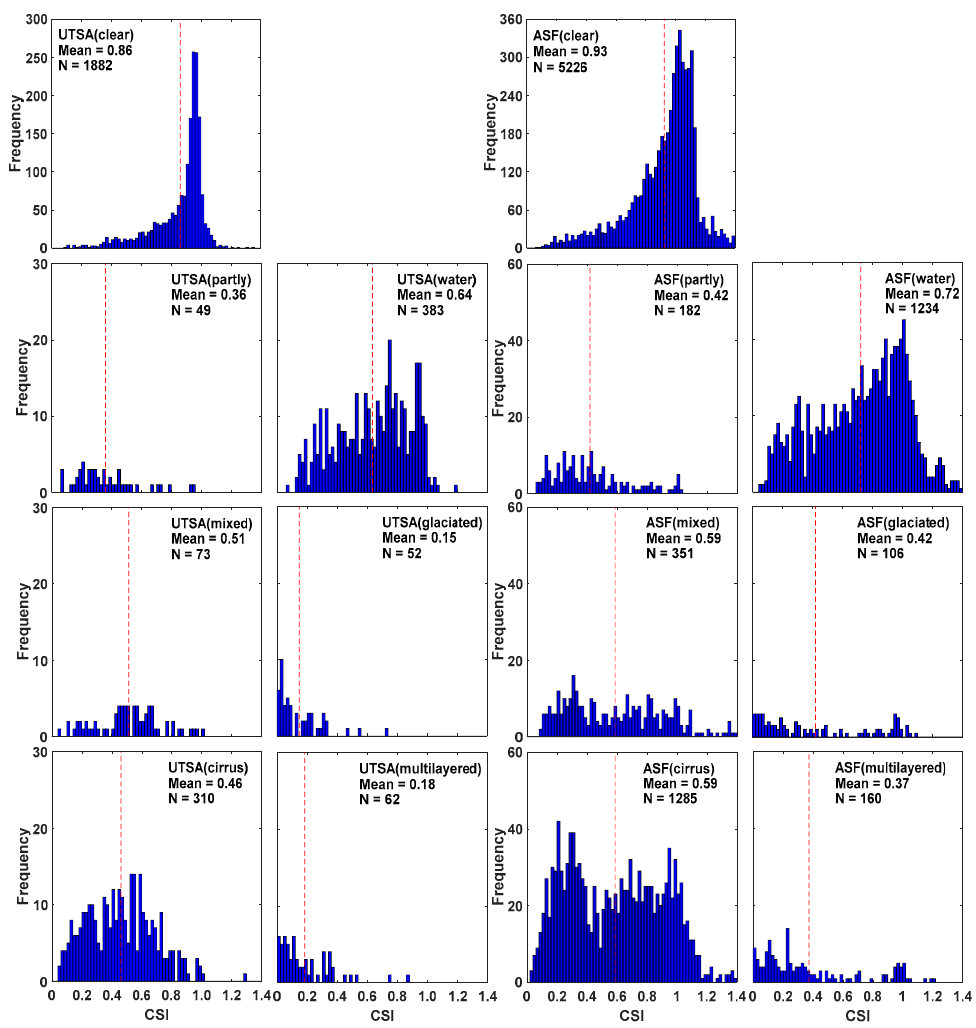
Figure 4. Histograms of the averaged CSI values from all available ground data at their original sampling rates for each cloud type at the UTSA station ( left two panel columns ) and ASF site ( right two panel columns ), with the red dashed line indicating the mean CSI for each cloud type.